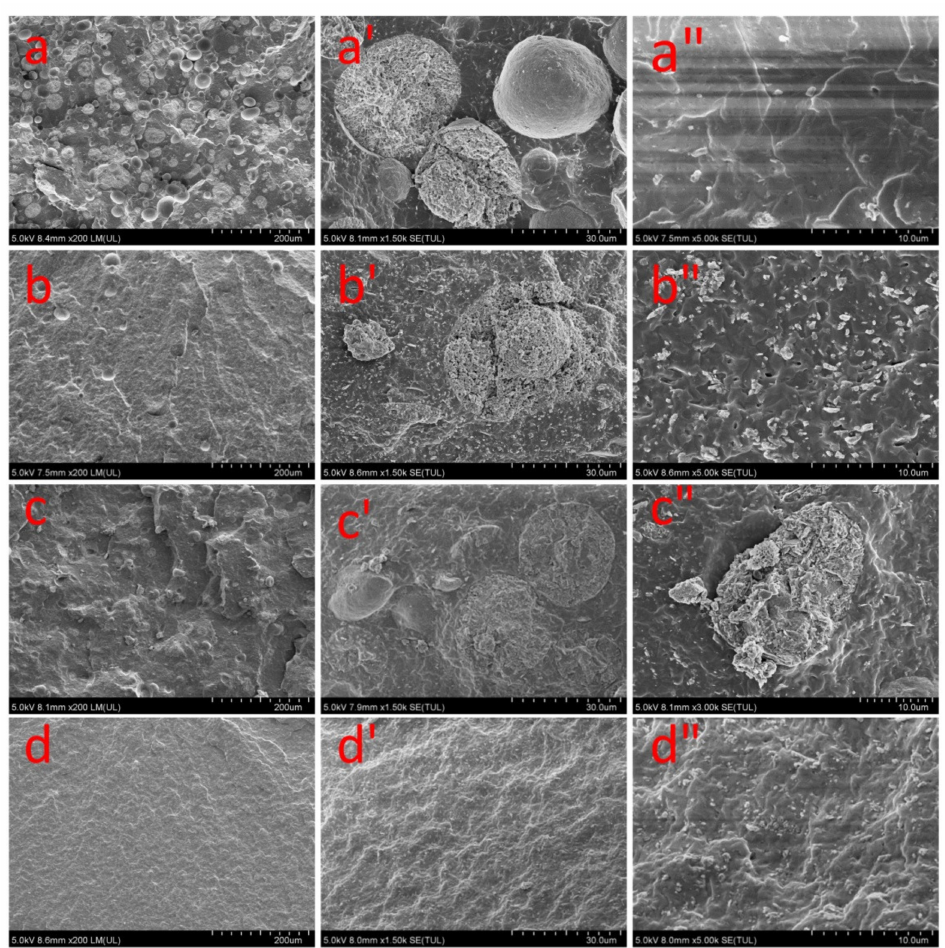
Figure 8. SEM observation of coal gangue/SBR composites: ( a , a’ , a” ) GR-SBR; ( b , b’ , b” ) GA-SBR; ( c , c’ , c” ) MGR-SBR; ( d , d’ , d” )